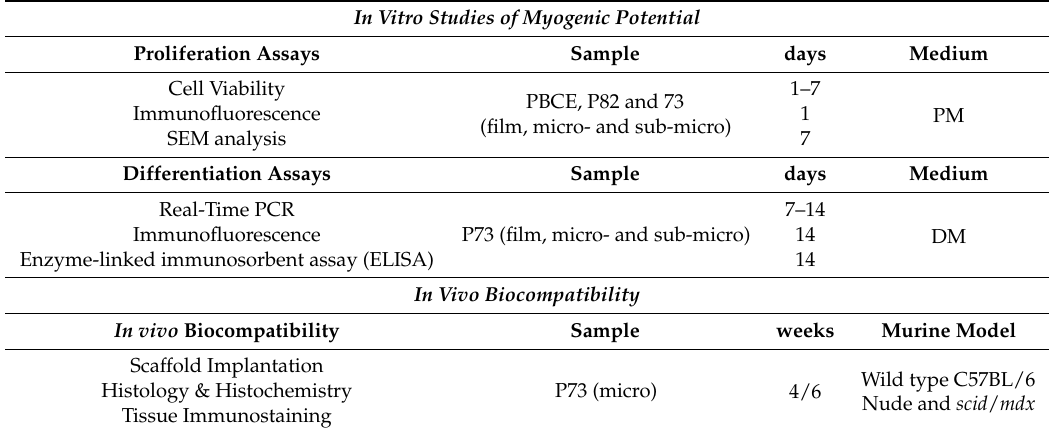
Table 1. Experimental